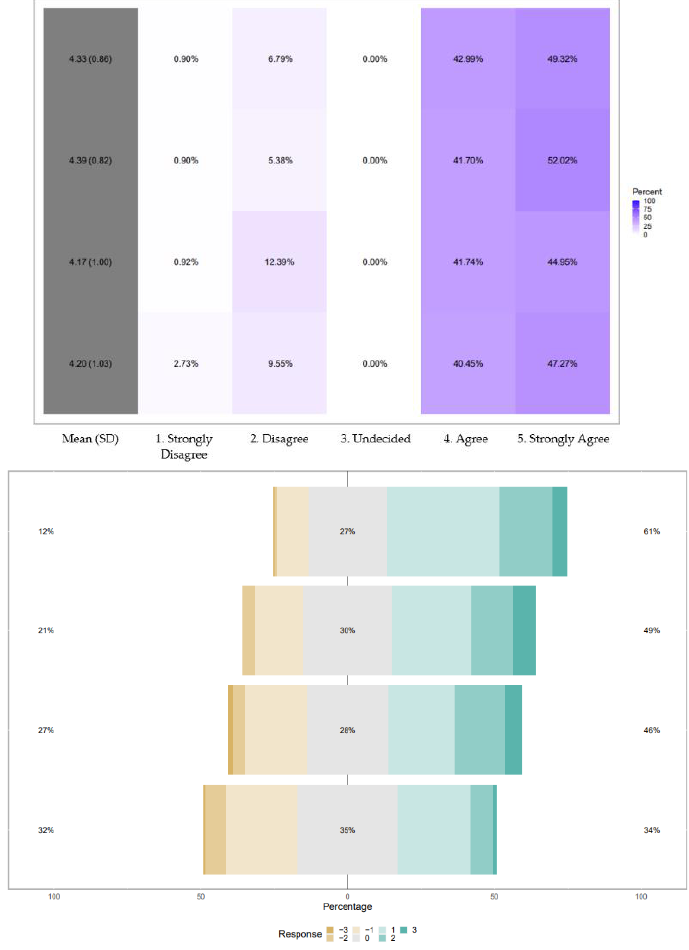
Figure 3. First objective: post-test ( top ) and differences between pre-test and post-test ( bottom ). Own elaboration.